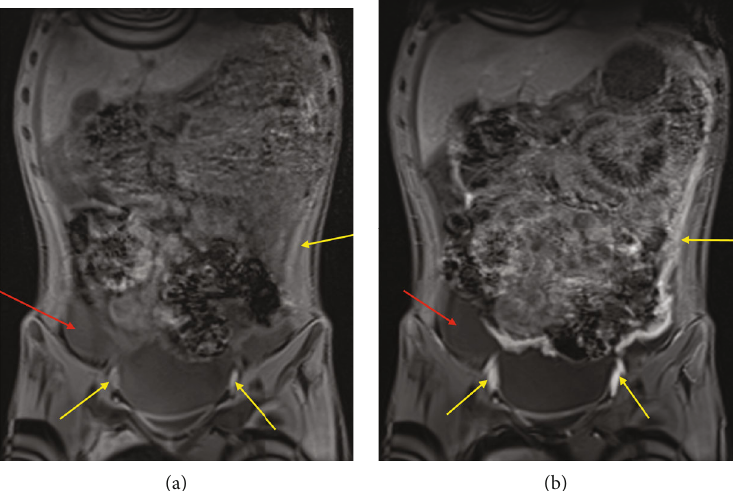
Figure 2: Coronal images before (a) and after (b) the administration of contrast demonstrating enhancement of the peritoneum and